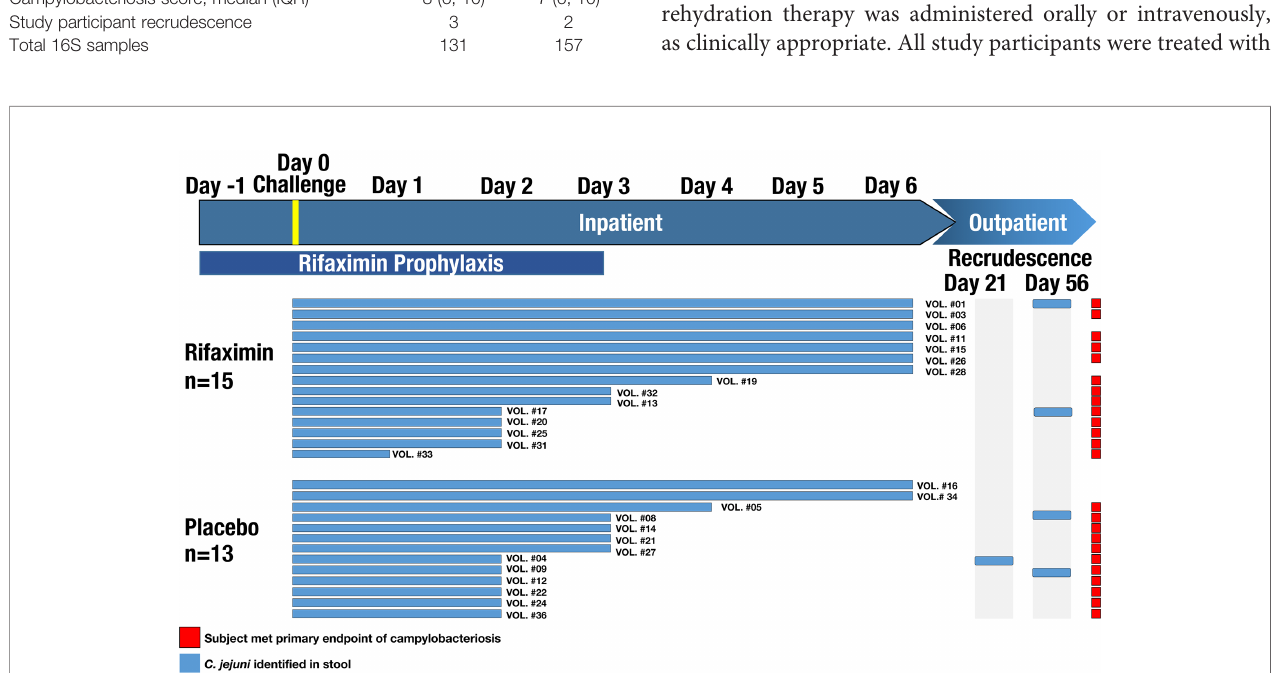
FIGURE 1 | Study design conceptual overview. The length of each study participant (SID) bar shows when C. jejuni was identi fi ed in their stool. Red squares denote which study participants met the endpoint of the study ( i.e. ,